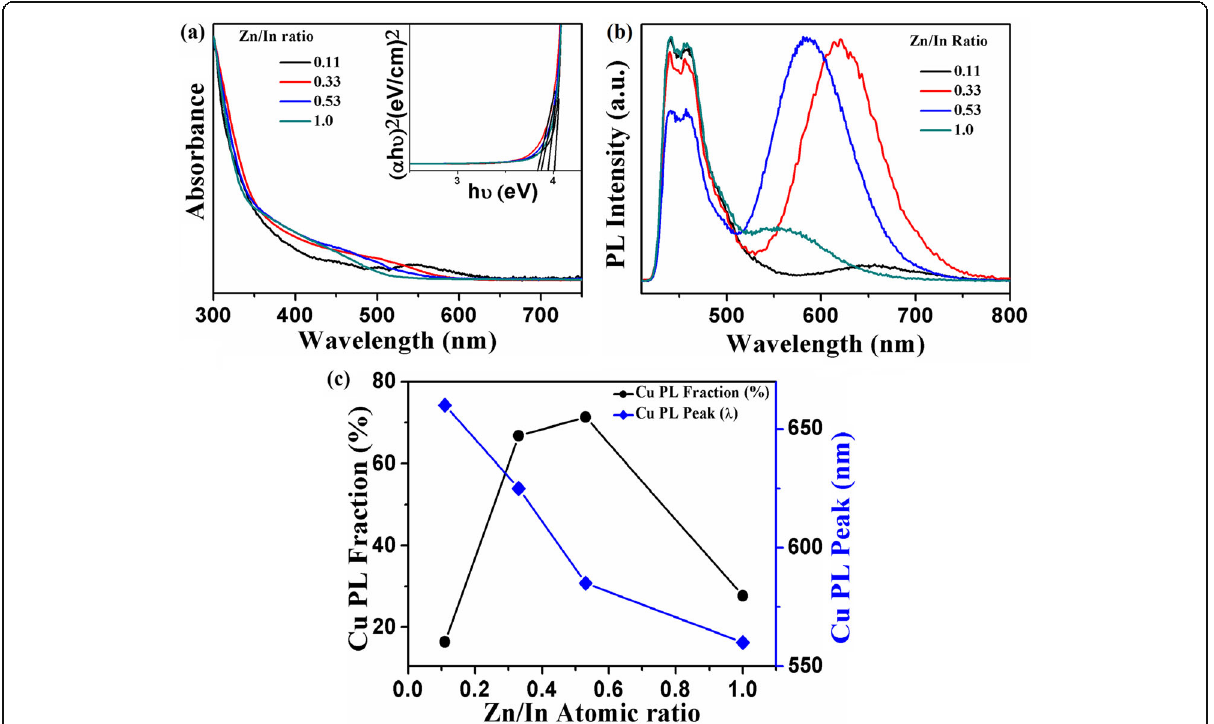
Fig. 5 a UV-visible absorption and b photoluminescence spectra of ZnInS:Cu core CNCs as a function of Zn/In stoichiometric composition. The inset in a shows the calculated energy band gap of ZnInS:Cu CNCs. c Shift of the Cu dopant PL peak position and Cu contribution (%) with respect to total integrated emission for different CNCs having variable Zn/In